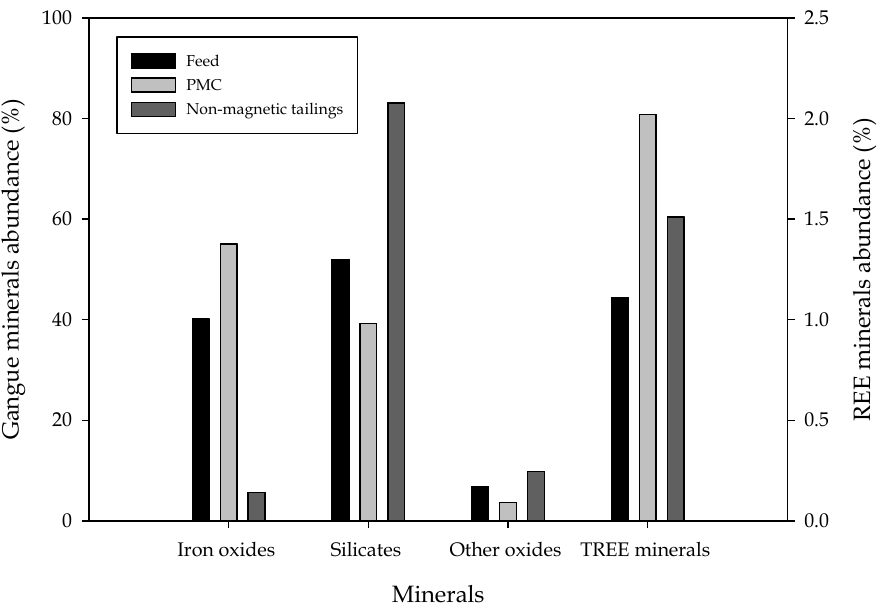
Figure 7. Mineral mass abundance of TREE and gangue minerals in the feed and magnetic (PMC and nonmagnetic tailings) products.